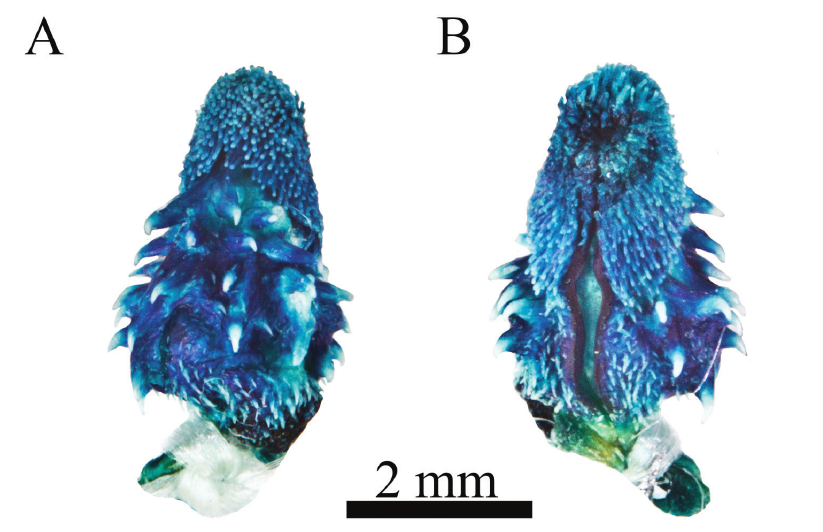
Figure 5. Right hemipenis of Rhadinaea nuchalis sp. n., holotype (MZFC-HE 22161). Asulcate ( A ) and sulcate ( B ) sides.